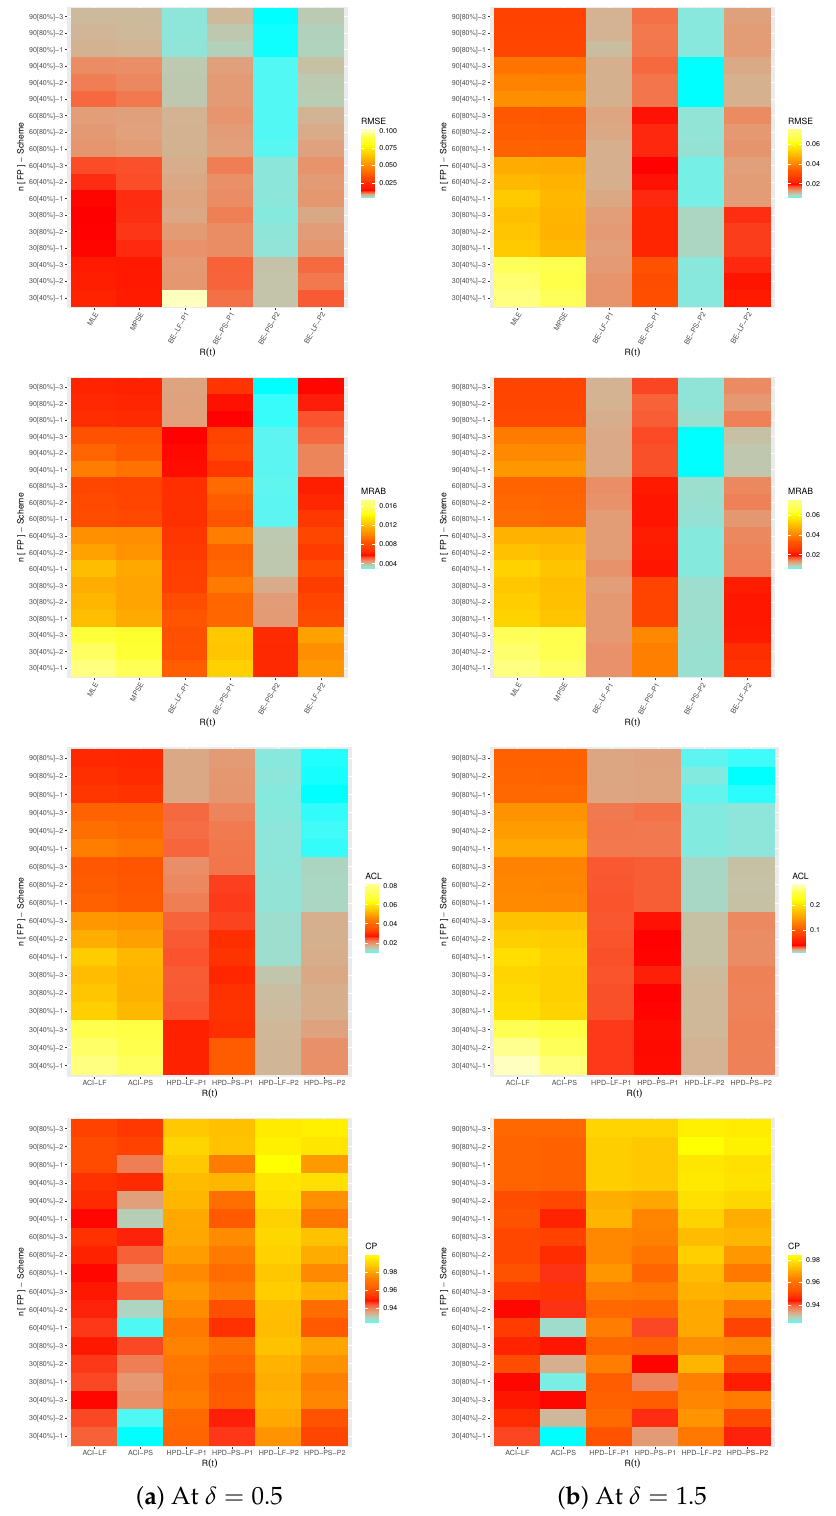
Figure 2. Heatmap plots for the simulation outputs of R ( t )